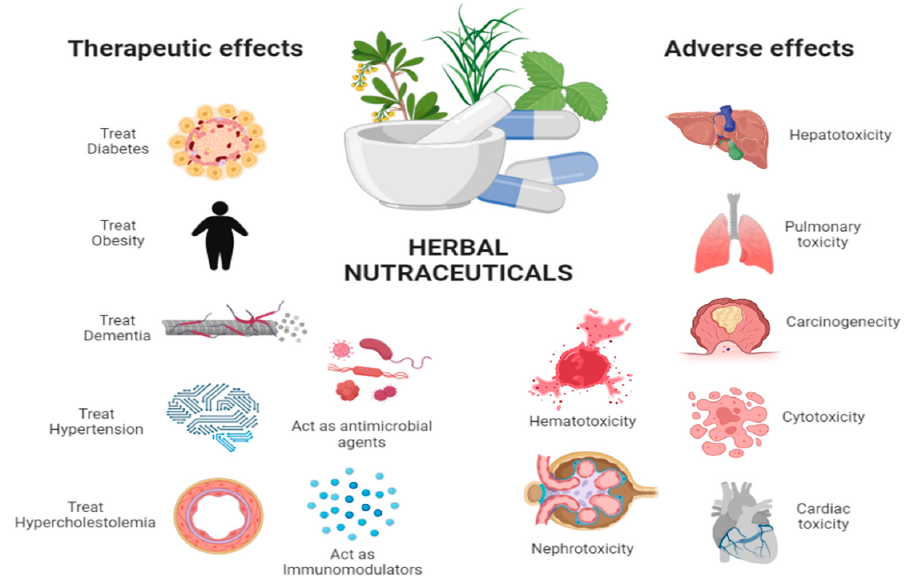
Figure 2. A summary of beneficial and adverse effects of nutraceuticals.